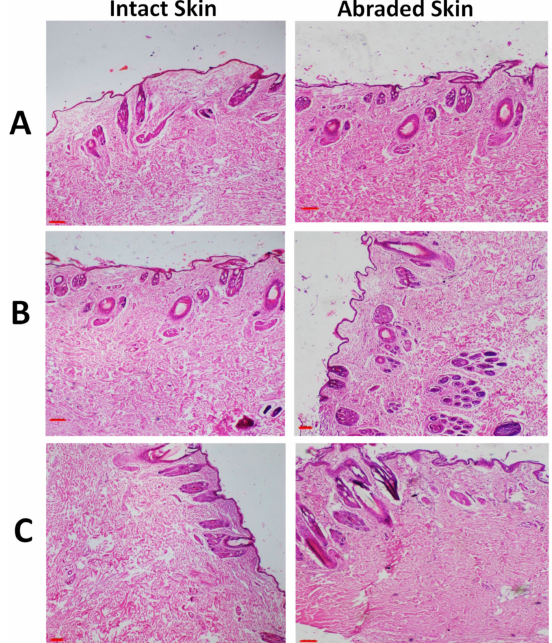
Figure 6. Representative images of H and E stained photomicrographs of skin for one representative rabbit after skin irritation test for ( A ) Group I; untreated group, act as a control, ( B ) Group II; Rhamnolipids nano-micelles solution group, and ( C ) Group III; PBS (10 mM, pH 7.4) treated group. All groups treated with samples showed normal histological tissue identical to untreated group after 72 h of treatment with samples. All skin layers appear normal and similar to control with the absence of any sign of erosion, ulcers, necrotic cells, or inflammatory cells. Scale bar, 100 µ m.